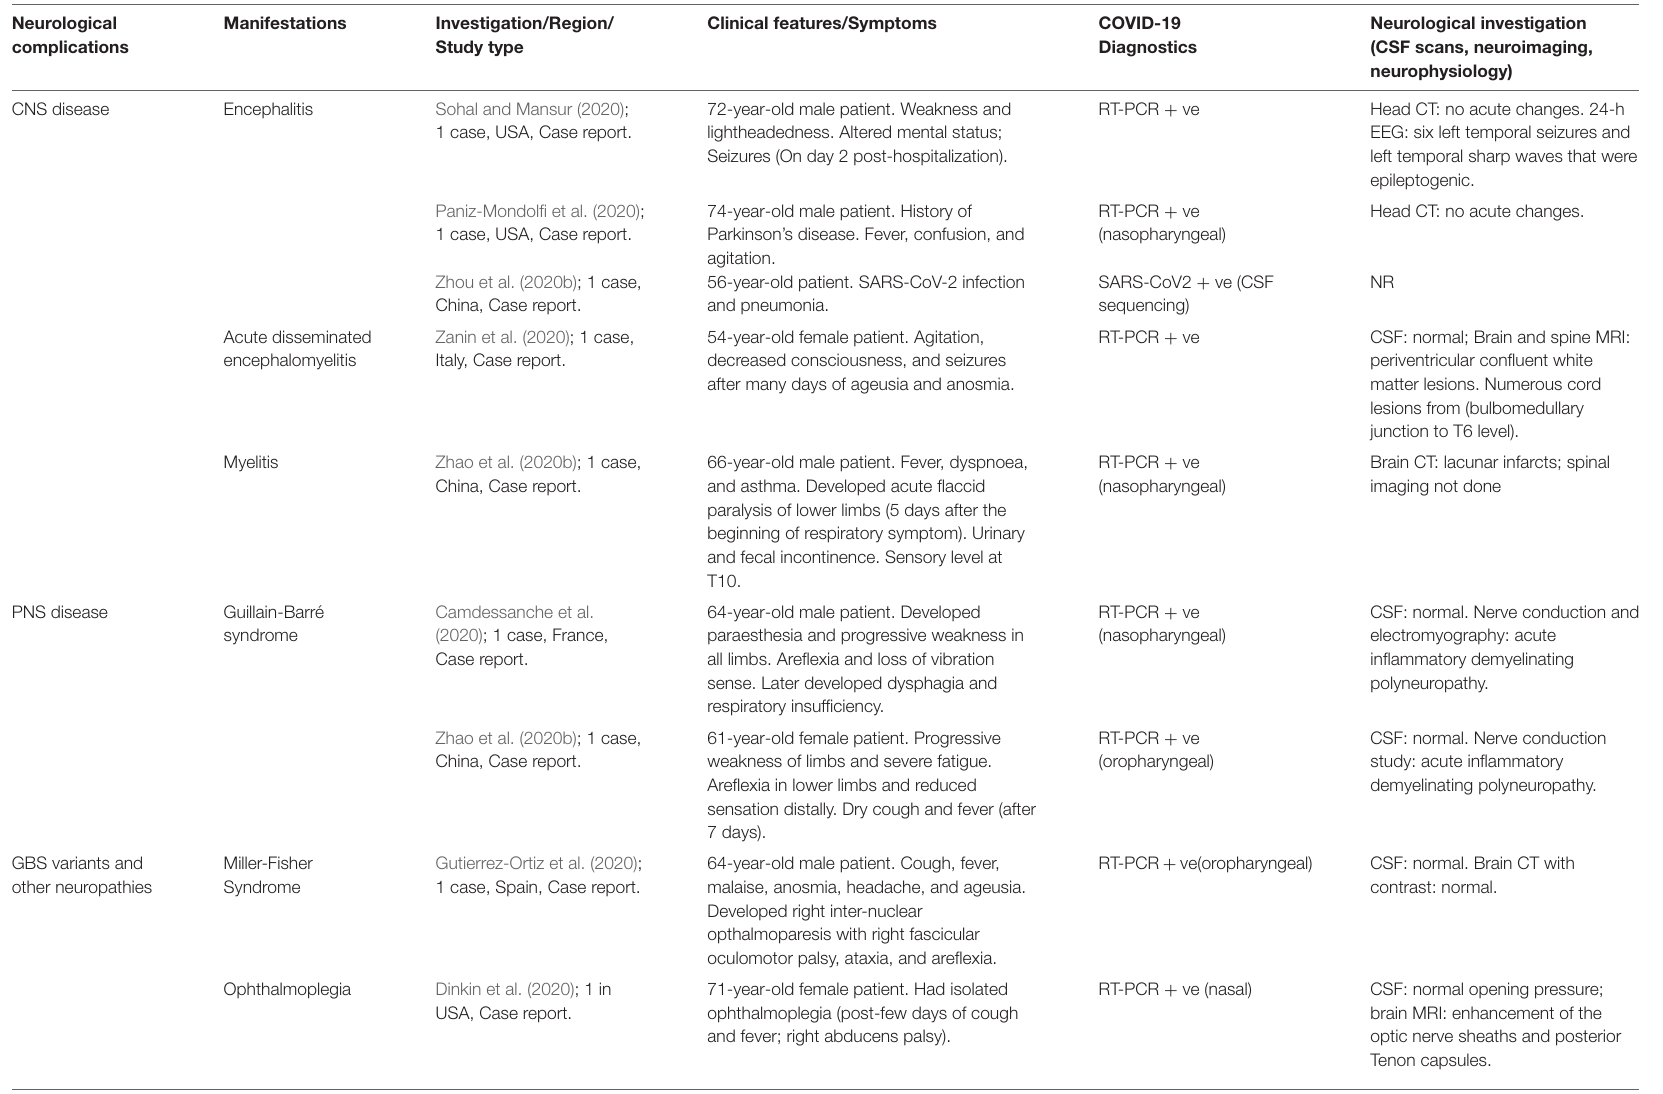
TABLE 1 | Summary of common peripheral nervous system (PNS), central nervous system (CNS), cerebrovascular, and intracerebral neurological complications in elderly Coronavirus disease 2019 (COVID-19)